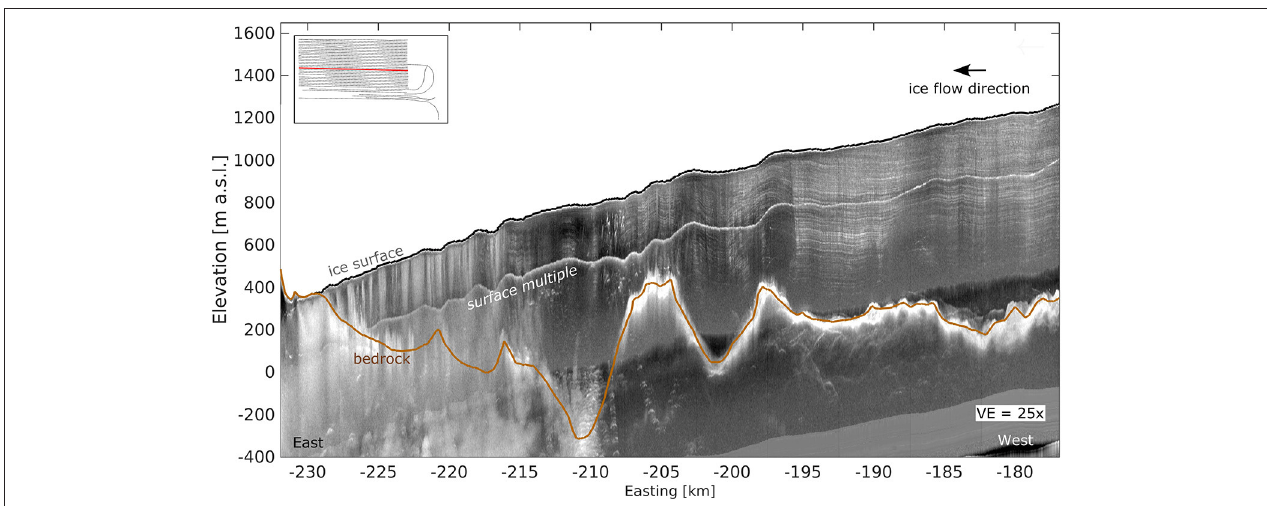
FIGURE 6 | IceBridge radargram showing internal layers along an ablation zone cross section. Ice flow is West to East. Ice surface (thin black line) and bed (brown line) picked from the radar data are shown. The thick bold white reflector at ∼ 1/3 ice depth is a surface multiple, an artifact of airborne radar depth sounding (data by Leuschen, 2011). Inset shows map view of IceBridge flight lines, with the extent of this radargram highlighted (red).